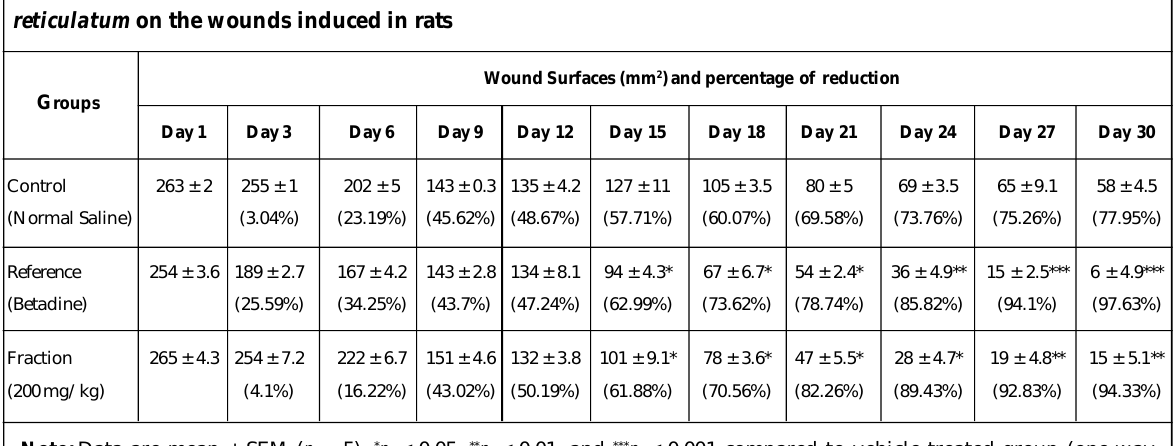
Table 1: Effects of betadine and dichloromethane fraction of an ethanol extract of stem bark of Piliostigma reticulatum on the wounds induced in rats